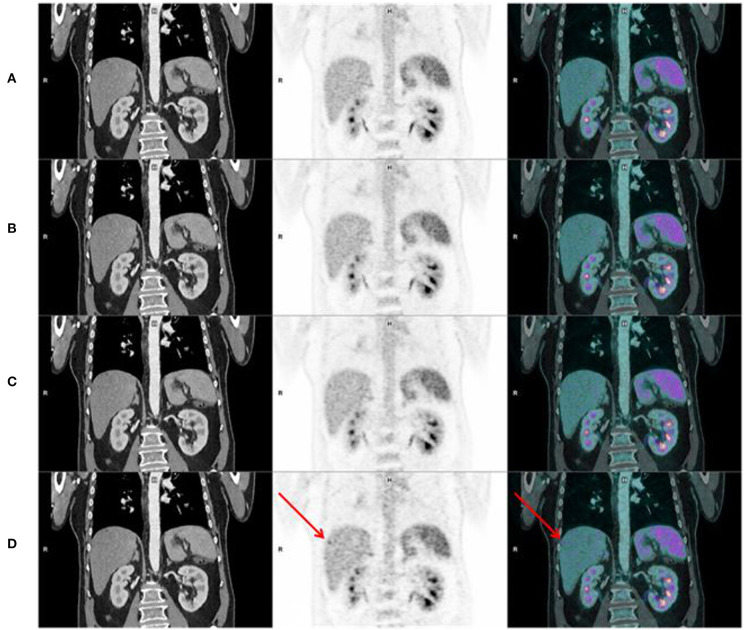
Coronal CT, PET, and fusion images in the same patient, showing better sharpness of organs, pyelo-ureteral uptakes, and less hepatic noise when increasing acquisition time [(A-D) from top to bottom, respectively, 120, 90, 60, and 30 s per bed position]. We can see noise on the “Analog-like” acquisition which can mimic focal uptake in the right liver (arrow), and which disappears on the other acquisitions.